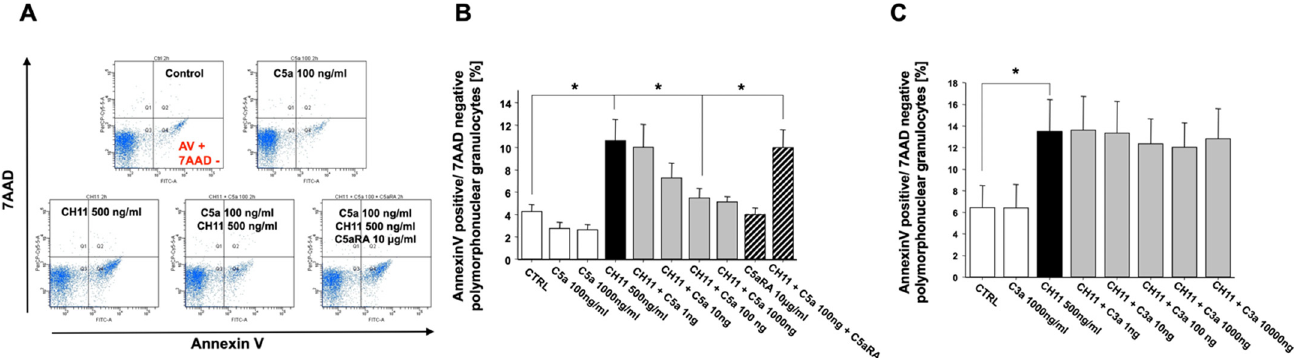
Figure 3. Inhibition of the extrinsic, CH11 (CD95)-induced apoptosis rate of freshly isolated PMN from healthy volunteers by exposure to C5a (concentration–response curve) in the absence or presence C5aR1 antagonist (C5aRA) ( n = 4) ( A : original flowcytometric recording; B : summary). ( C ) Similar conditions under C3a exposure ( n = 3). The percentage of apoptotic PMN was determined by Annexin-V/7-AAD staining and flow cytometry. Results are shown as mean ± SEM. * = p < 0.05.